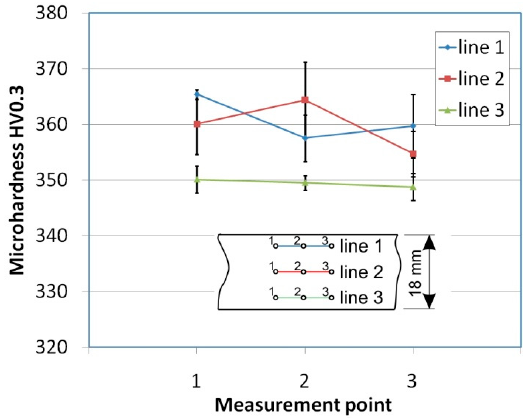
Figure 2. Results of the microhardness measurements.